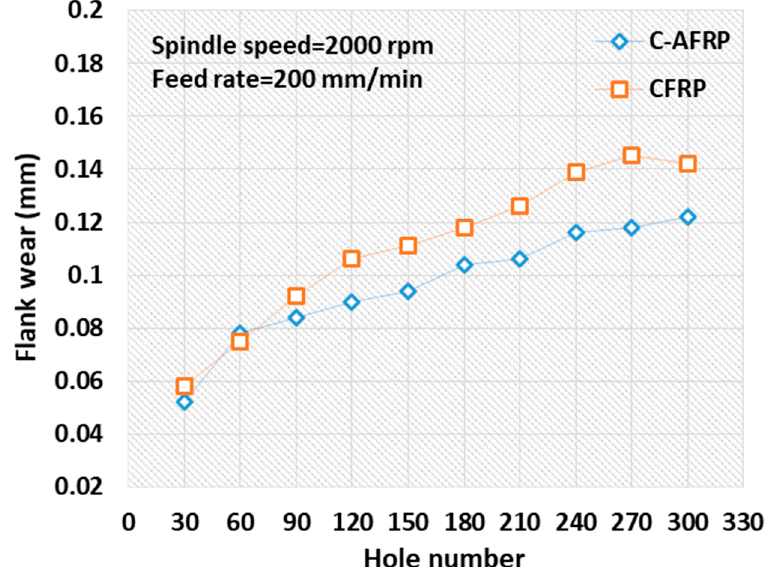
Figure 10. Tool wear in drilling of CFRP and C-AFRP according to hole number.